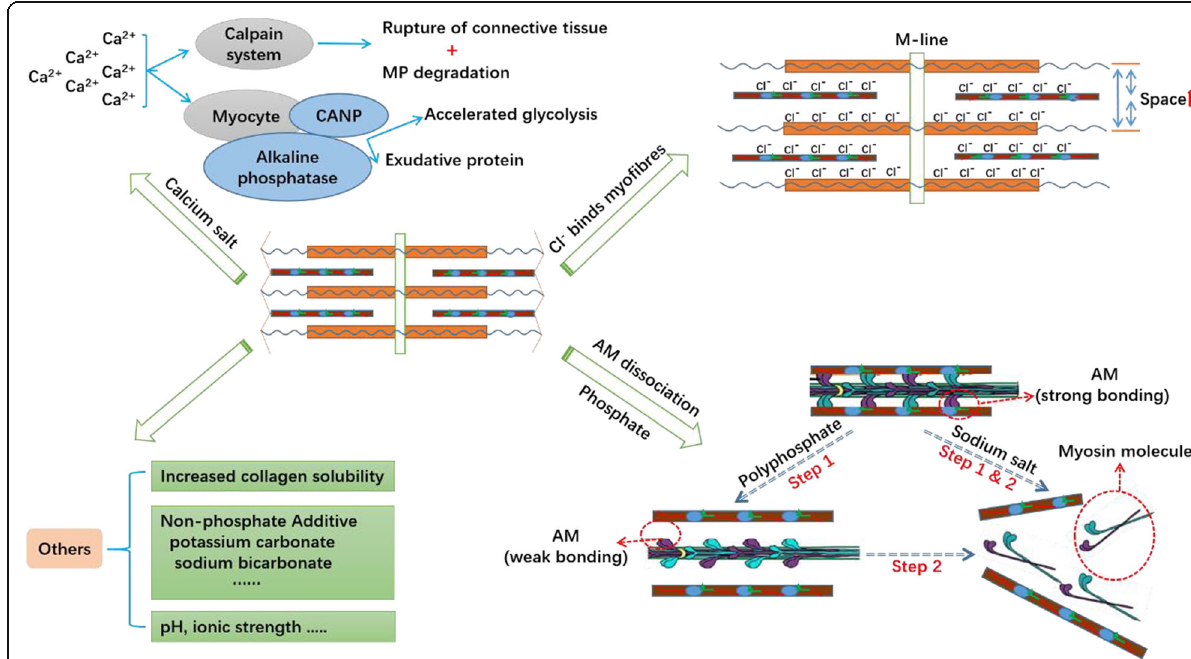
Fig. 5 Schematic representation of salt tenderisation. Step 1: myosin dissociates from actin. Step 2: myosin dissociates from the thick filament. The presence of phosphate can decrease the concentration of sodium salt required for the maximum extraction of myosin by weakening the binding force of actomyosin (the concentration required for actomyosin (AM) dissociation by sodium salt alone is